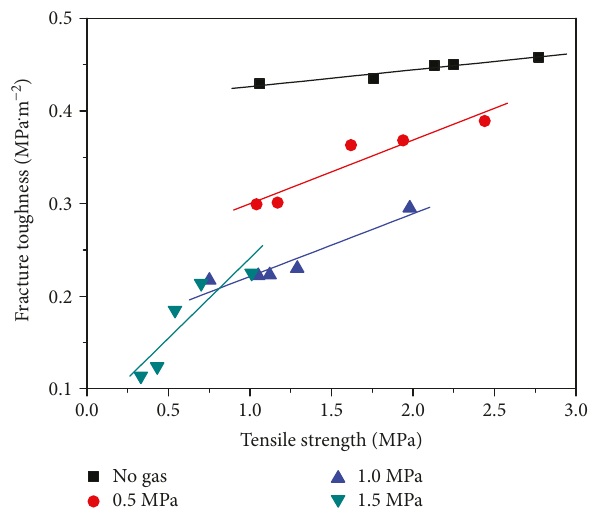
Figure 9: Relationship of fracture toughness against tensile strength under di ff erent gas pressures. Table 2: Fitting function relationships.